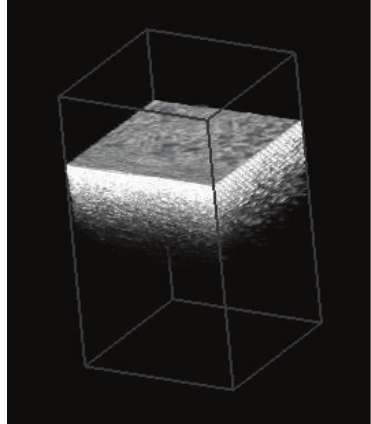
Figure 4: This shows a volumetric image of the egg shell. The 3D image is constructed from real OCT scans. The dimensions of the scanned volume were 𝑥 = 0.5 mm: 𝑦 = 0.5 mm: 𝑧 = 1.6